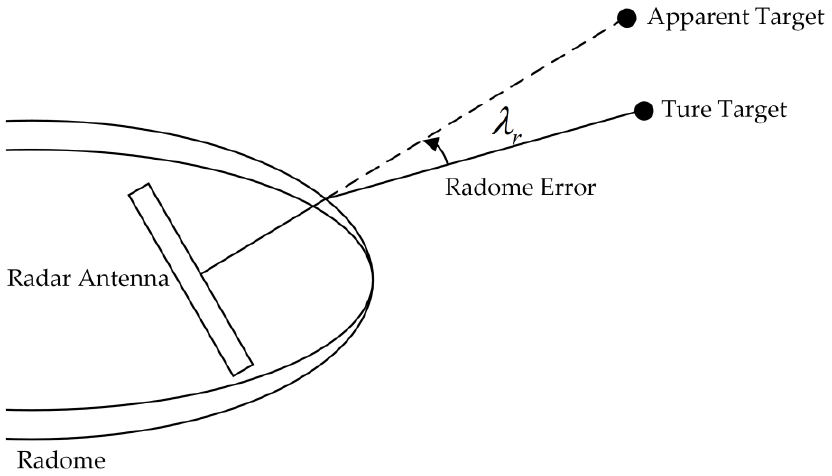
Figure 1. Radome refraction physics.